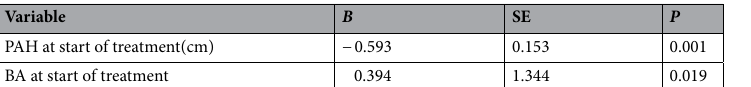
Table 5. Multiple regression analysis of factors influencing height gain (FAH–initial PAH) in treated girls. (n = 22, R 2 = 0.764). Stepwise regression linear regression of the following independent variable: BA,